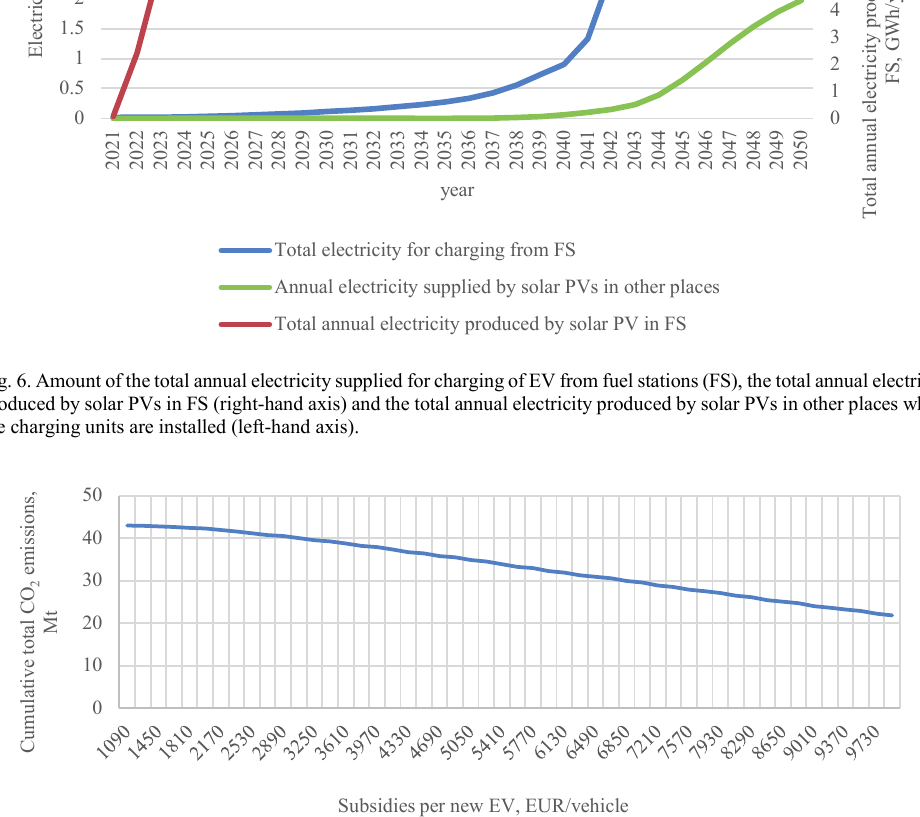
Fig. 7. Cumulative total CO 2 emissions depending on the subsidies per new